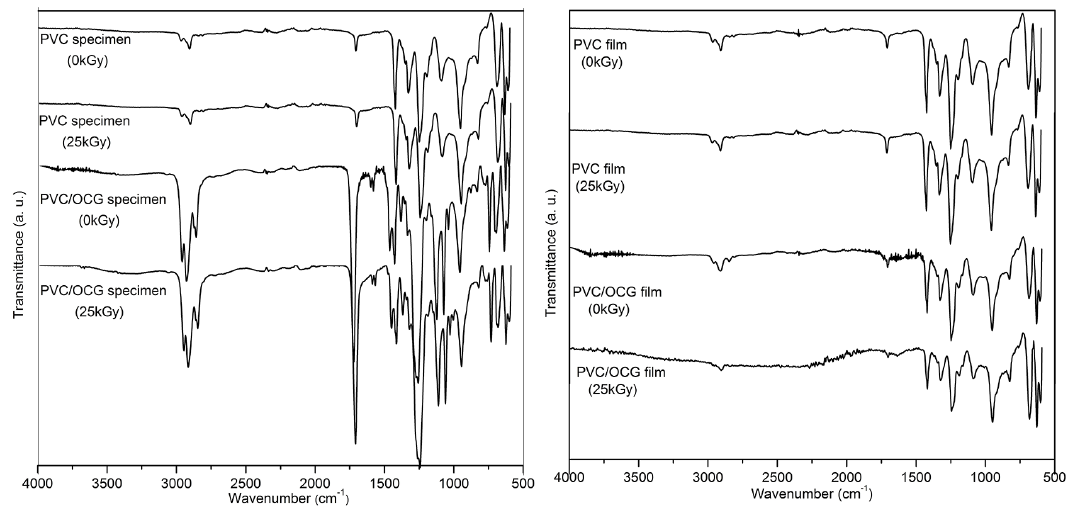
Figure 2. FT-IR spectra obtained for a) PVC specimen and b) PVC film Table 3. Peak assignments for FT-IR spectra of PVC and PVC/OCG systems Absorption peak (cm -1